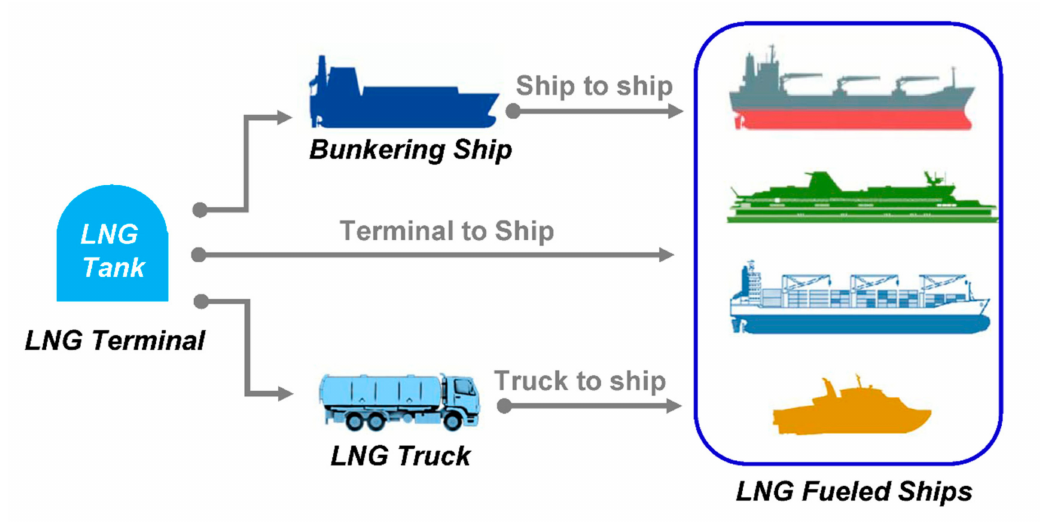
Figure 1. Schematic representation of the di ff erent bunkering methods.